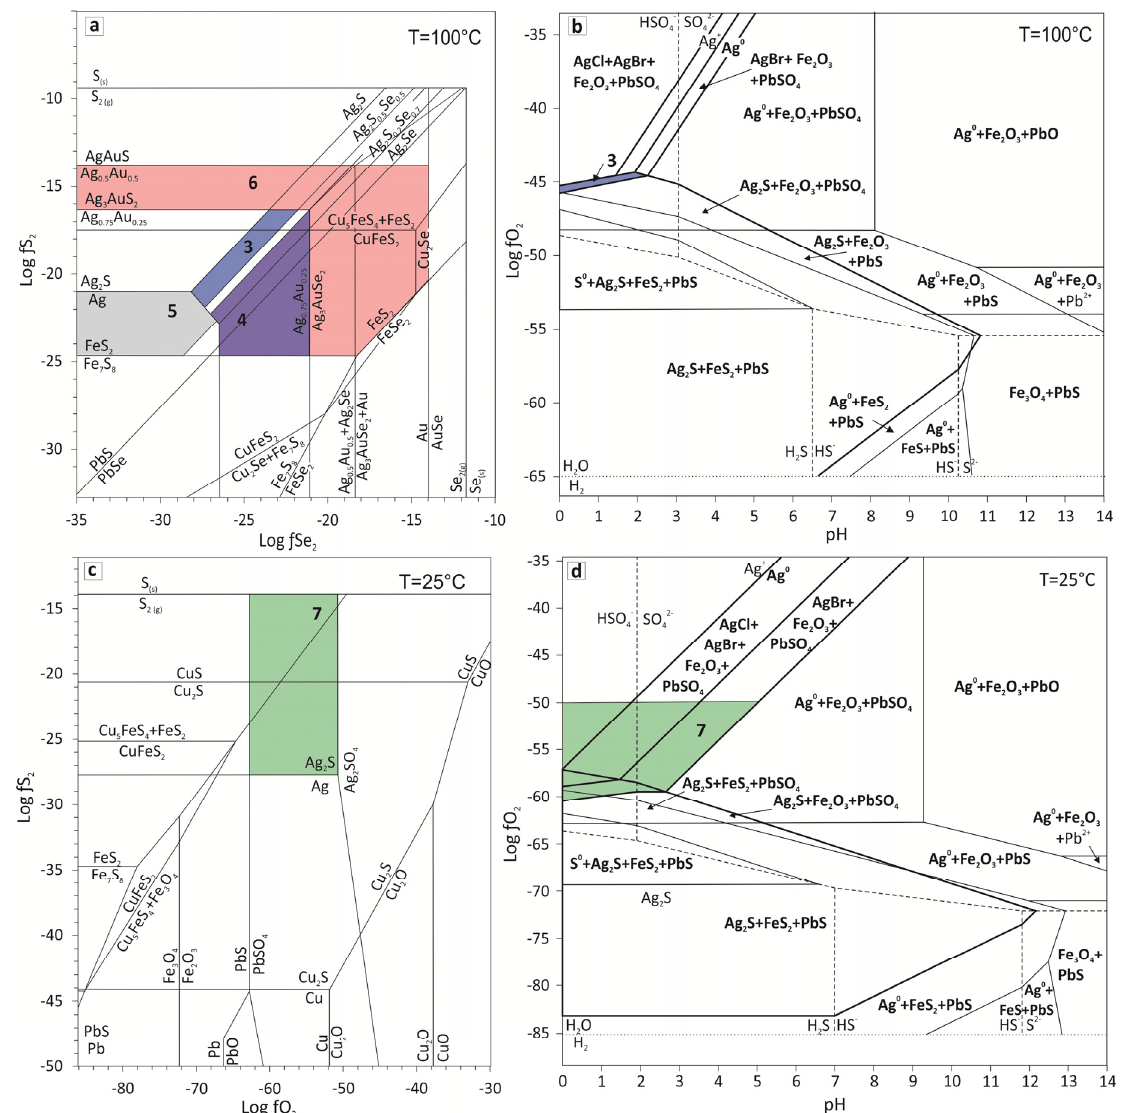
Figure 9. Diagrams of logƒS 2 –logƒSe 2 ( a ) and logƒ О 2 –pH ( b ) at 100 ◦ C, logƒS 2 –logƒO 2 ( c ) and logƒ О 2 –pH ( d ) at 25 ◦ C, and stability fields of the Corrida mineral associations: field 3—Se-acanthite (Ag 2 S − Ag 1.94 S 0.52 Se 0.54 ) + Ag halides; field 4—S-naumannite (Ag 1.94 S 0.33 Se 0.73 − Ag 2 Se) + clausthalite (PbSe); field 5—Au-Ag solid solutions; field 6—uytenbogaardtite-fischesserite; field 7—acanthite + chlorargyrite + bromargyrite + anglesite (PbSO 4 ). Element concentrations used in calculation: [S] = 10 − 2 M, [Cl] = 10 − 1 M, [Br] = 10 − 2 M, [Ag] = 10 − 7 M.